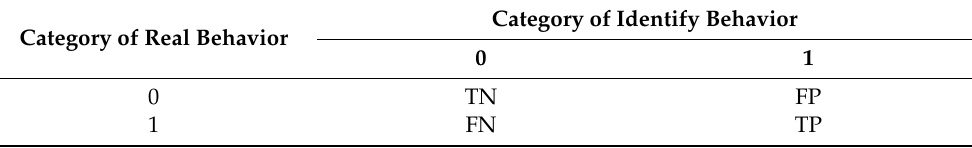
Table 2. Confusion matrix of SCAD-logit